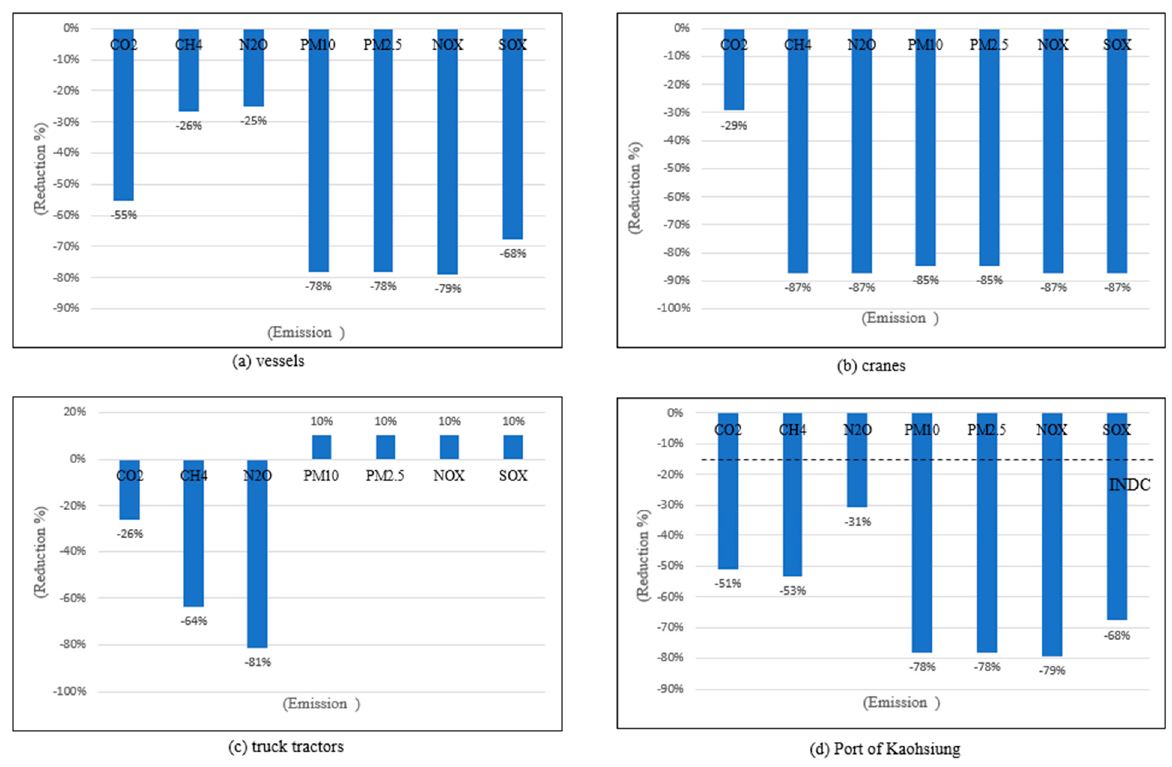
Figure 4. The emissions from vessels, cranes, truck tractors, and the Port of Kaohsiung using reduction policies in the first stage.